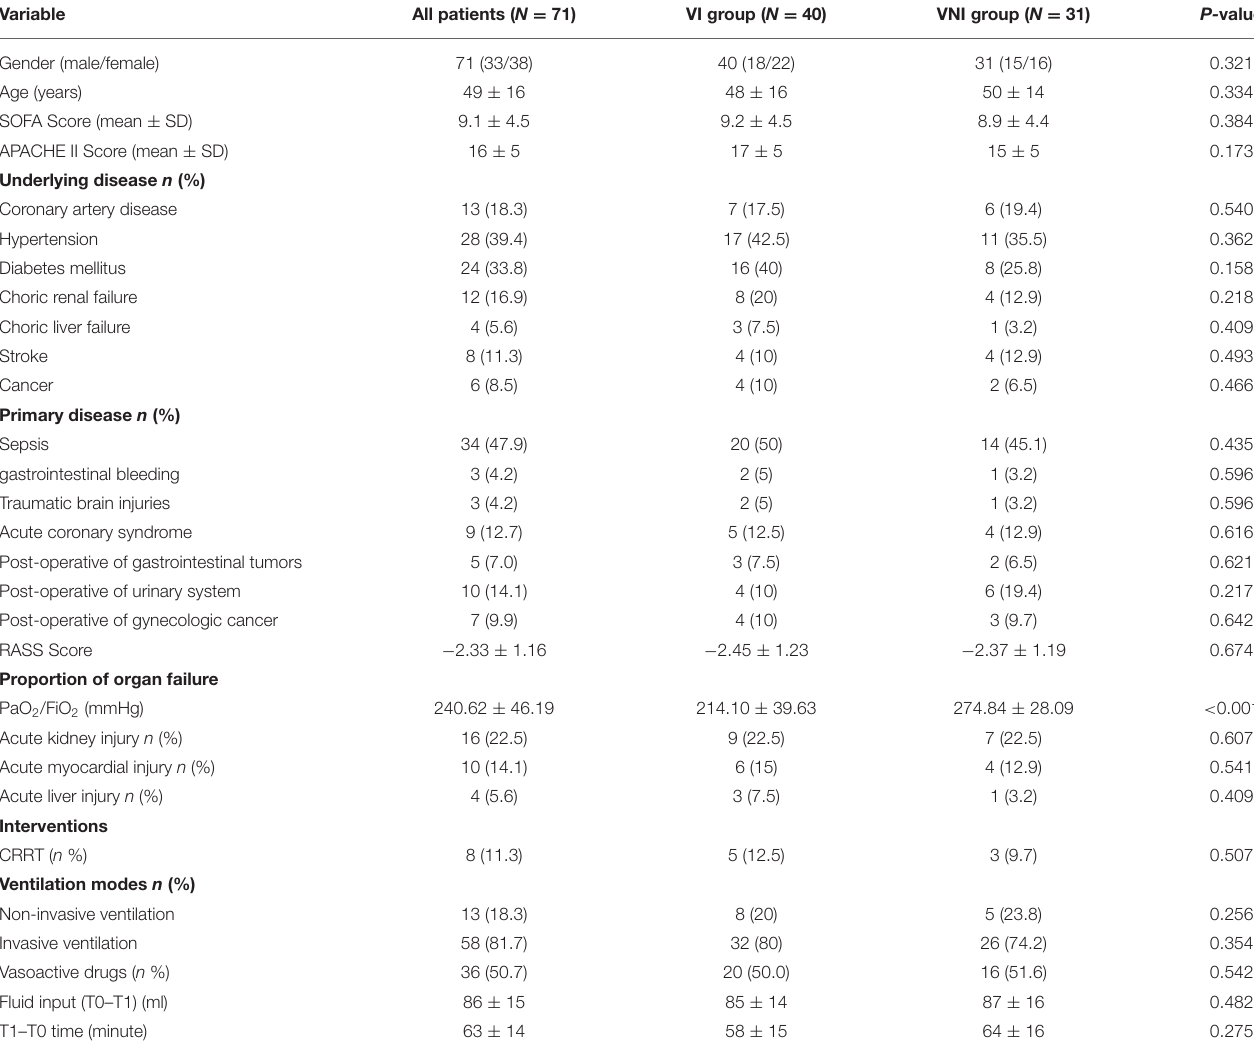
TABLE 1 | The demographic and clinical characteristics of the patients included in this study at T0. Variable All patients ( N = 71) VI group ( N = 40) VNI group ( N = 31) P-